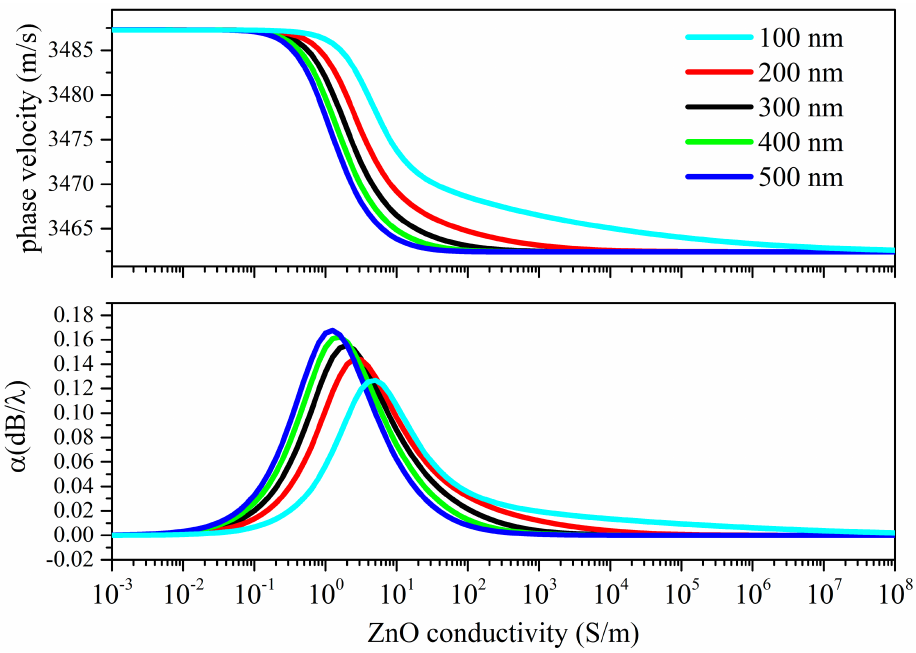
Figure 10. Sezawa wave phase velocity and propagation loss vs. conductivity curves under top illumination; the penetration depth is the running parameter.